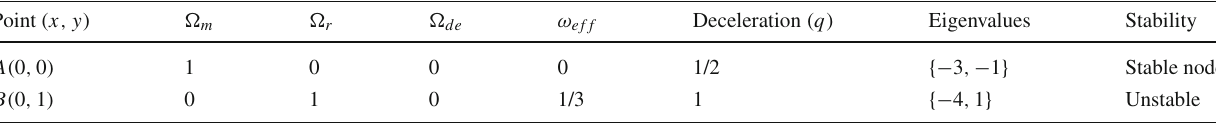
Table 1 Critical points for the dynamical system of the considered model Point ( x , y